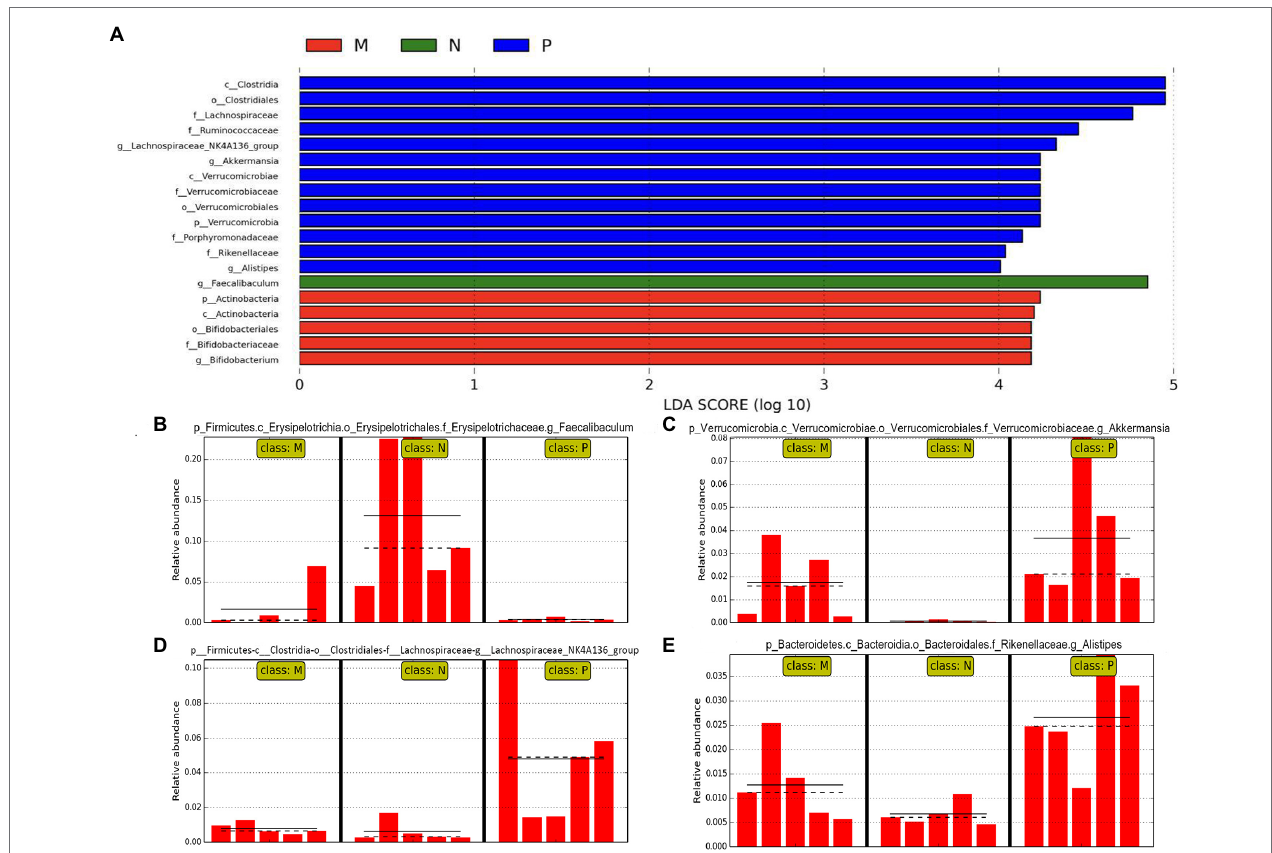
FIGURE 5 | Lactiplantibacillus plantarum 0111 increased the abundance of Faecalibaculum to maintain gut balance. LEfSe analysis was performed to assess changes in gut microbes. (A) LDA scores obtained in LEfSe analysis of gut microbiota from different groups. A LDA effect size of greater than 3 was used as a threshold for the LEfSe analysis. (B) Faecalibaculum , (C) Akkermansia , (D) Lachnospiraceae -NK4A136-group, and (E) Alistipes abundance analysis in different groups. P, challenged H9N2 cells after pretreatment with PBS; M, challenged H9N2 cells after pretreatment with L. plantarum 0111; N, pretreatment with PBS.